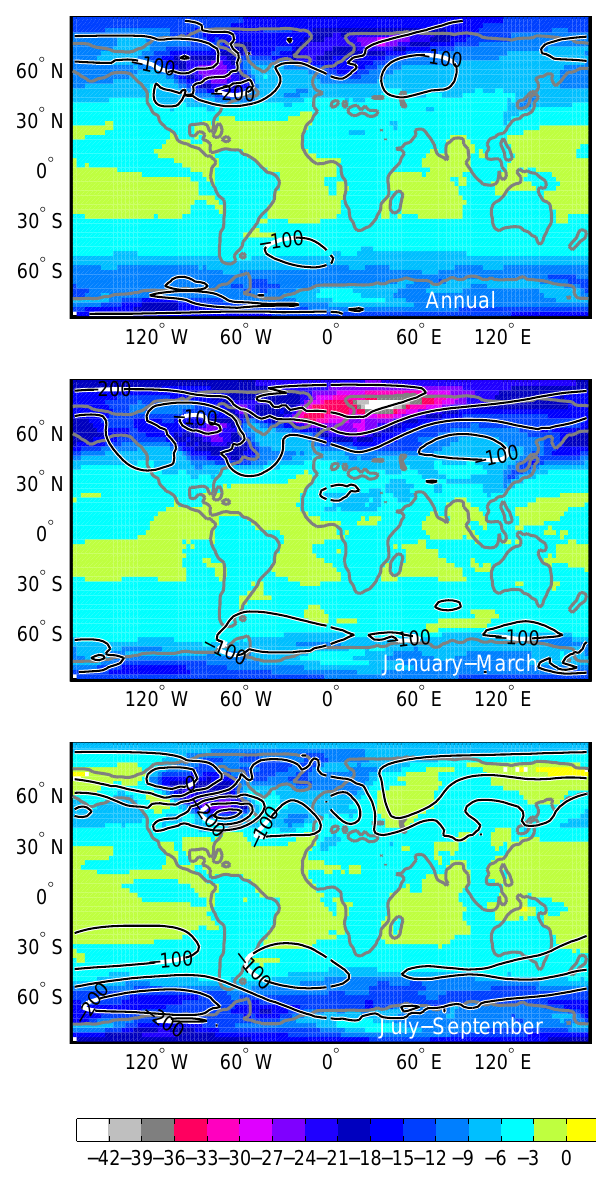
Fig. 5. Difference between GS12 and RP T 2m (shading) and geopo- tential height at the 300-hPa surface (isolines) for annual mean (top panel), JFM (middle panel), and JAS (bottom panel). Isolines for geopotential height are displayed for every 50 geopotential meter. The coastline is defined at 20% of the land